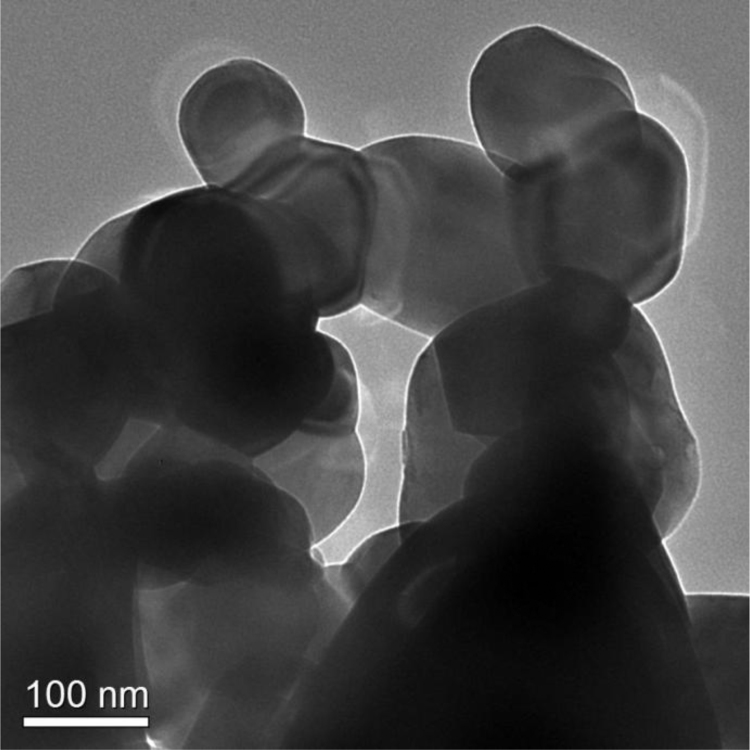
The HRTEM image of nanocrystalline La2Mo2O9 prepared by glycine auto ignition method.